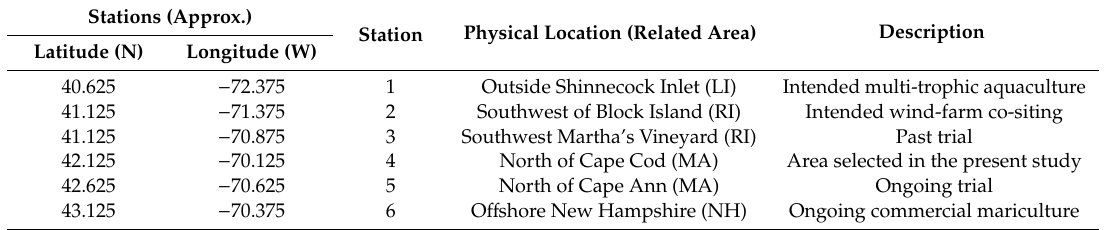
Table 2. Locations of the study stations and their